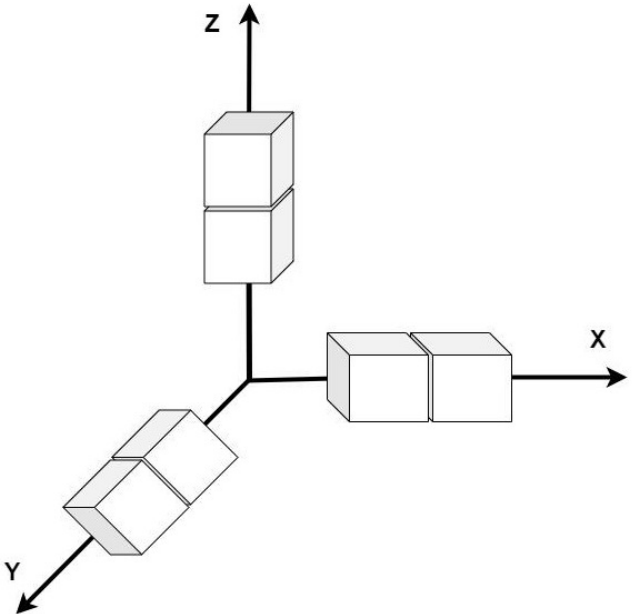
Figure 3. 3D Sobel operation in x, y and